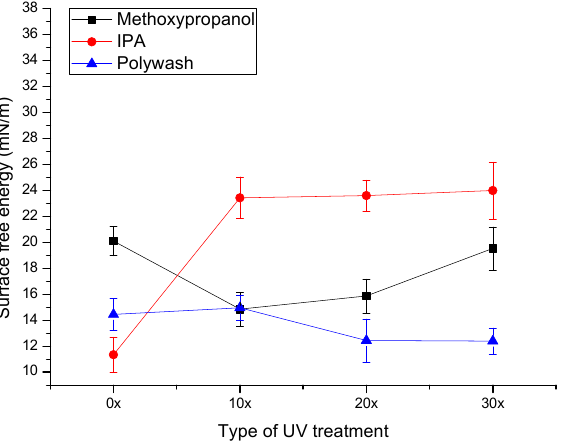
Figure 7. Surface free energy of the modified EPDM printing plate samples after exposure to solvents.